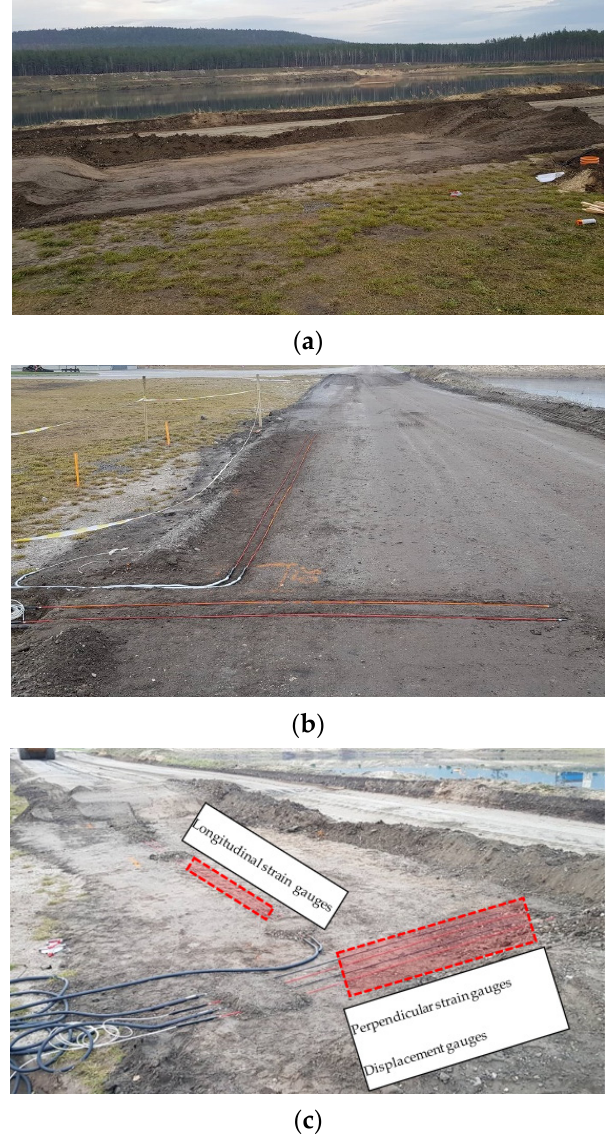
Figure 3. Trial section construction process: ( a ) subgrade preparation for the installation of sensors in the bottom part of the CRM-FB_5C base course; ( b ) sensor installation under the CRM-FB_5C base layer; ( c ) sensor installation under the wearing/binder layer of the JENA type SMA16 mixture.